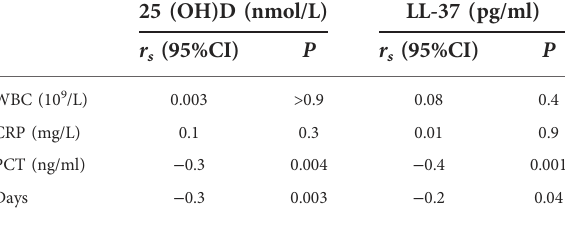
infection in children. There is a correlation between recurrent upper respiratory tract infection and vitamin D de fi ciency,